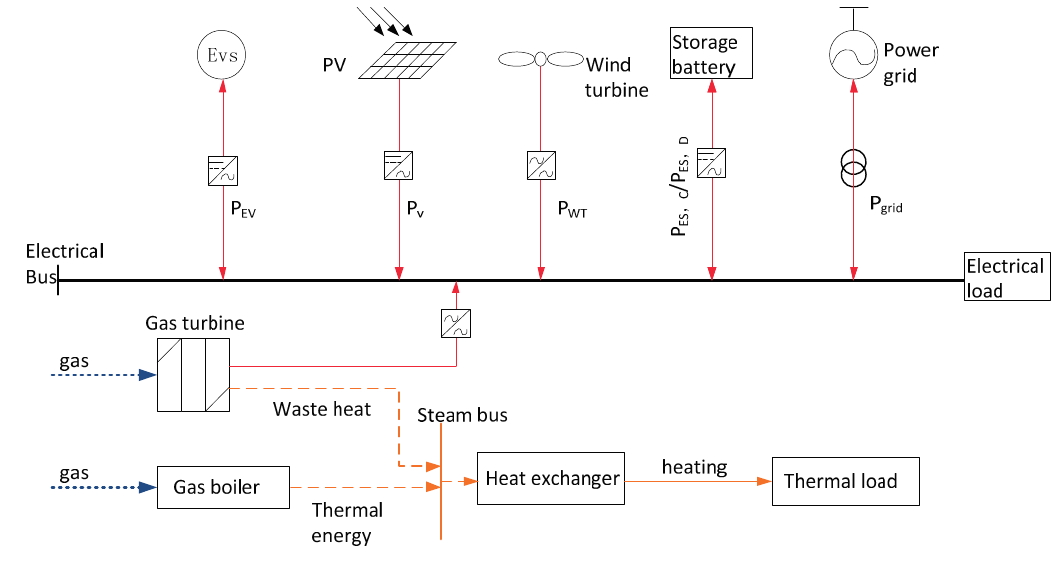
Figure 2. Hybrid energy microgrid system chart.